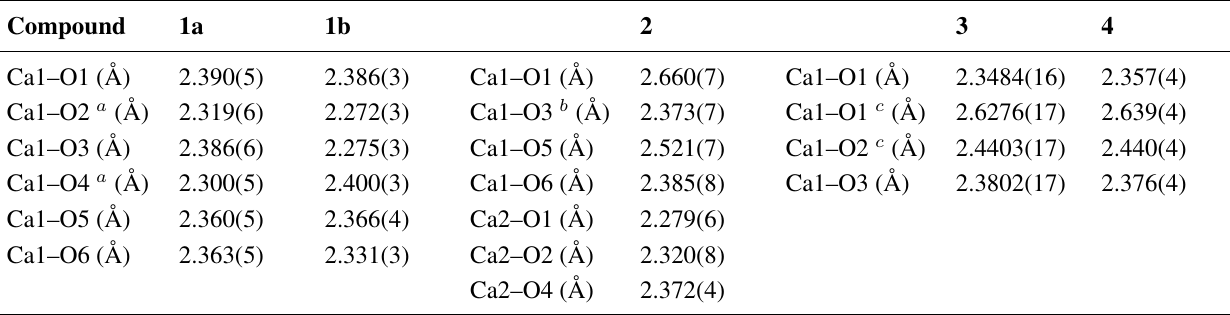
Figure 2. Left: Asymmetric unit of 1a and 1b with labeling scheme as displacement ellipsoid plot (80% probability) and adjacent atoms as stick model. Right: Polymeric chains of 1a and 1b with kite (red) and parallelogram (blue) shaped bridges, approximate twofold symmetry with circles highlighting the stereo chemistry of the amino groups, and labeled syn and anti bridges. Table 2. Selected interatomic distances of all